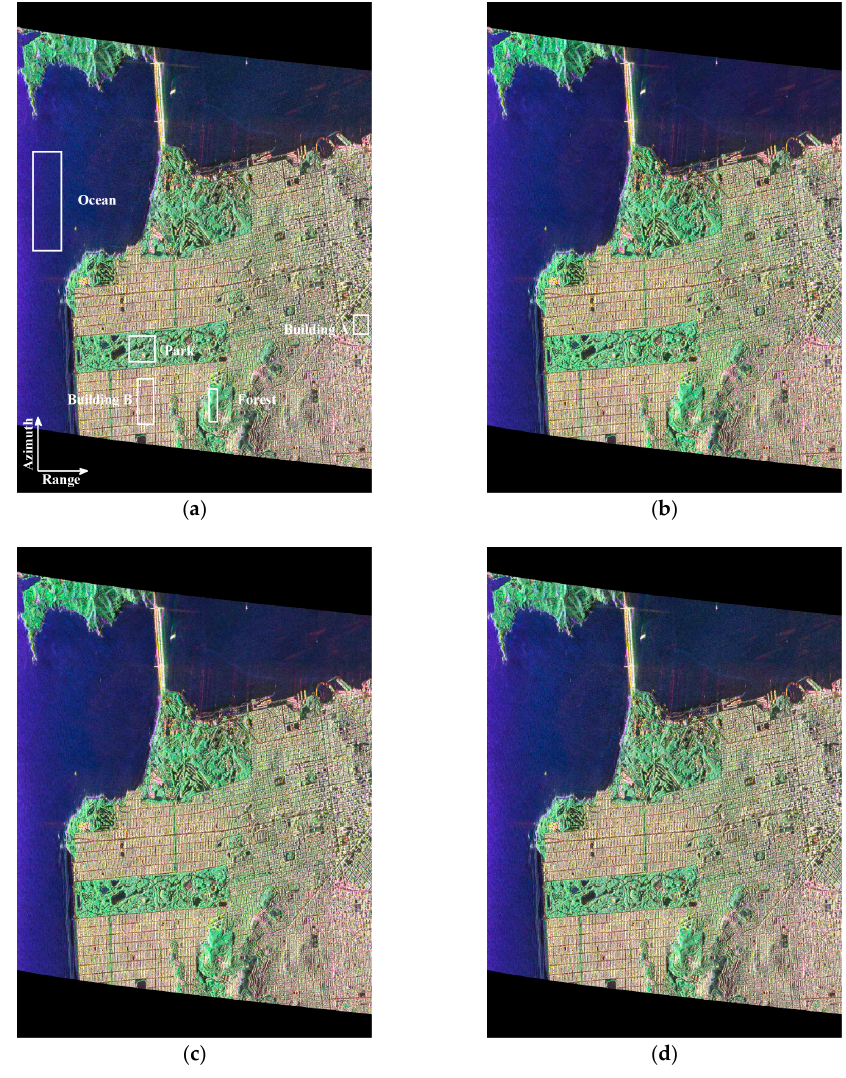
Figure 8. Decomposition results from L-band AIRSAR data over San Francisco area. ( a ) Yamaguchi decomposition with orientation compensation; ( b ) Modified Chen decomposition by using modified parameter inversion algorithm; ( c ) Proposed GMD–GVSM decomposition; ( d ) Proposed GMD–SAVSM decomposition. The images are colored by Pd (red), Pv (green), Ps (blue).